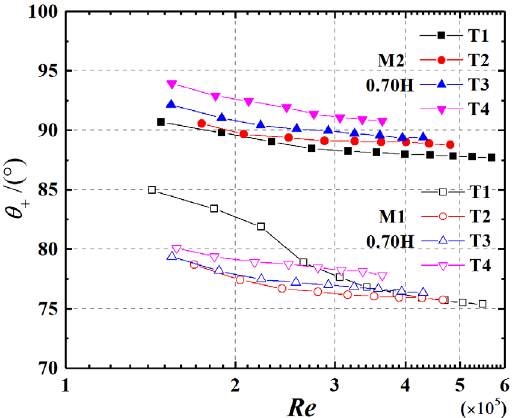
Figure 10. The variation of positive pressure range with Re under different wind fields.